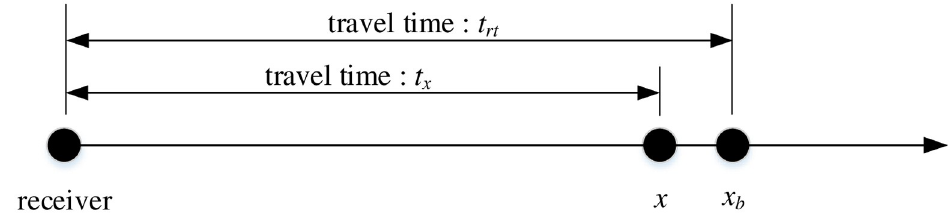
Fig 4. 1D schematic illustration of updating theoretical travel